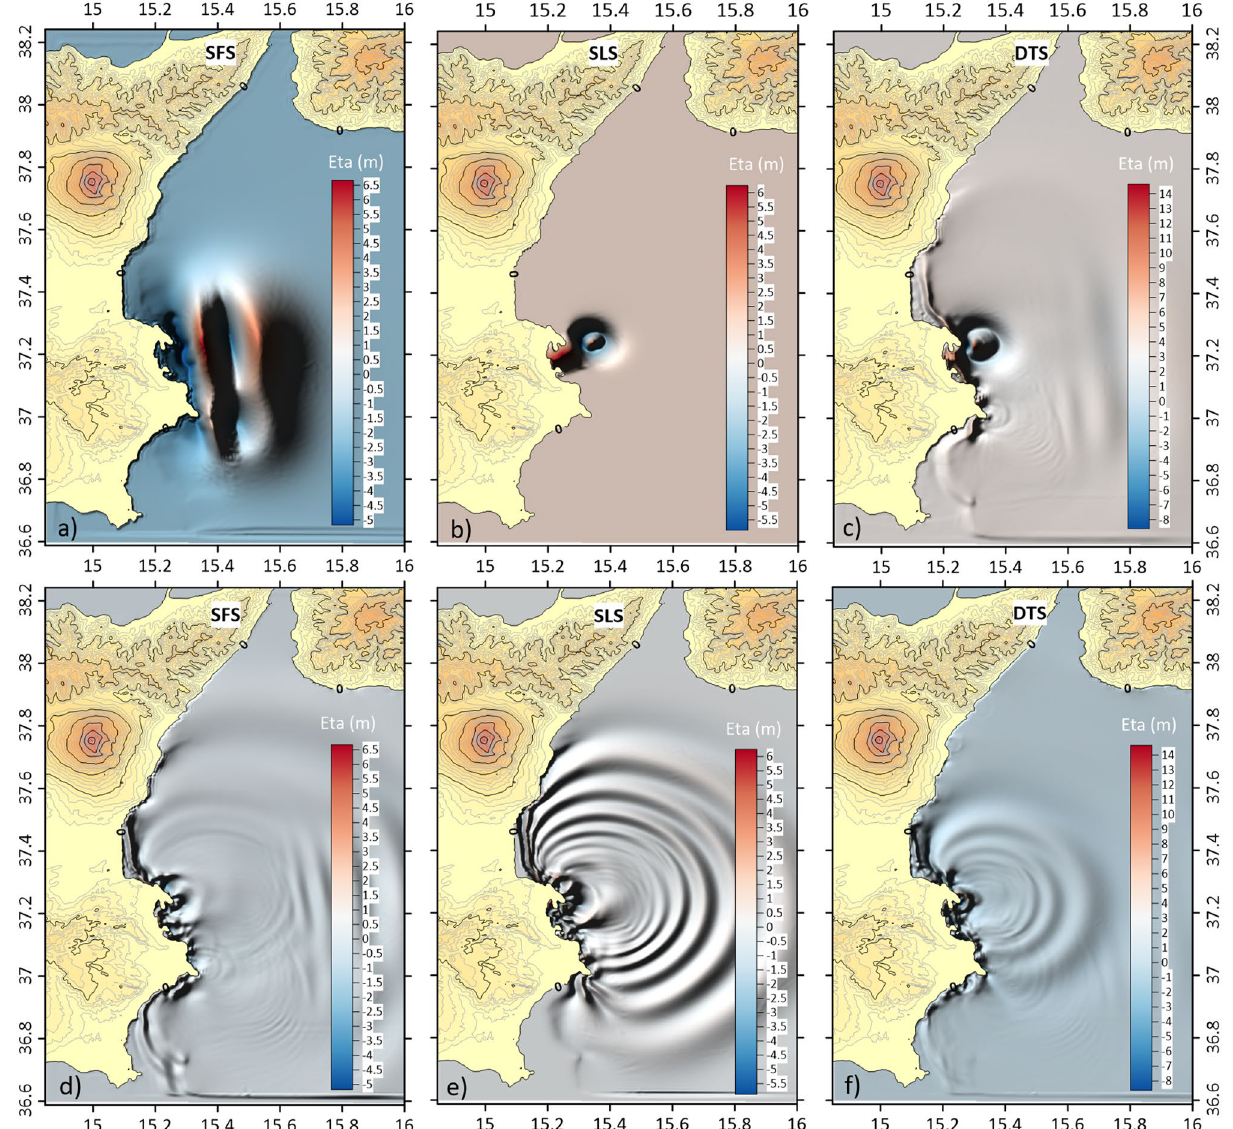
Figure 6. Initial sea-surface elevation (m) and wave impacting the coast under different scenarios. Simulations after 60 s of the starting event: ( a ) SFS—earthquake-generated tsunami; ( b ) SLS—submarine landslide- generated tsunami; ( c ) DTS—dual mechanism due to earthquake and submarine landslide. Simulations after 9 min of the starting event: ( d ) SFS—earthquake-generated tsunami; ( e ) SLS—submarine landslide-generated tsunami; ( f ) DTS—dual mechanism due to earthquake and submarine landslide. The maps were obtained by co-authors through QGIS—software (version 3.14.16); https:// www. qgis. org/ it/ site/, license Creative Commons. Attribution-Share Alike 3.0 licence (CC BY-SA) integrated with ESRI World